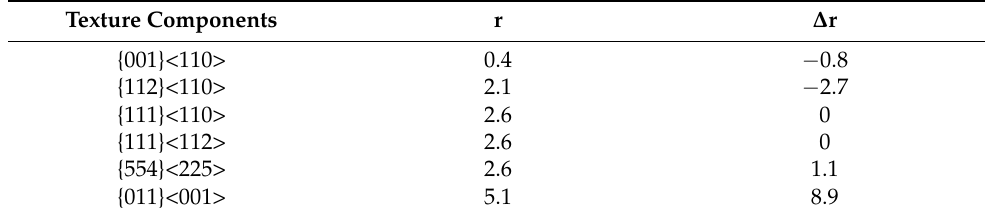
Table 3. Relationship between the r-value and texture composition